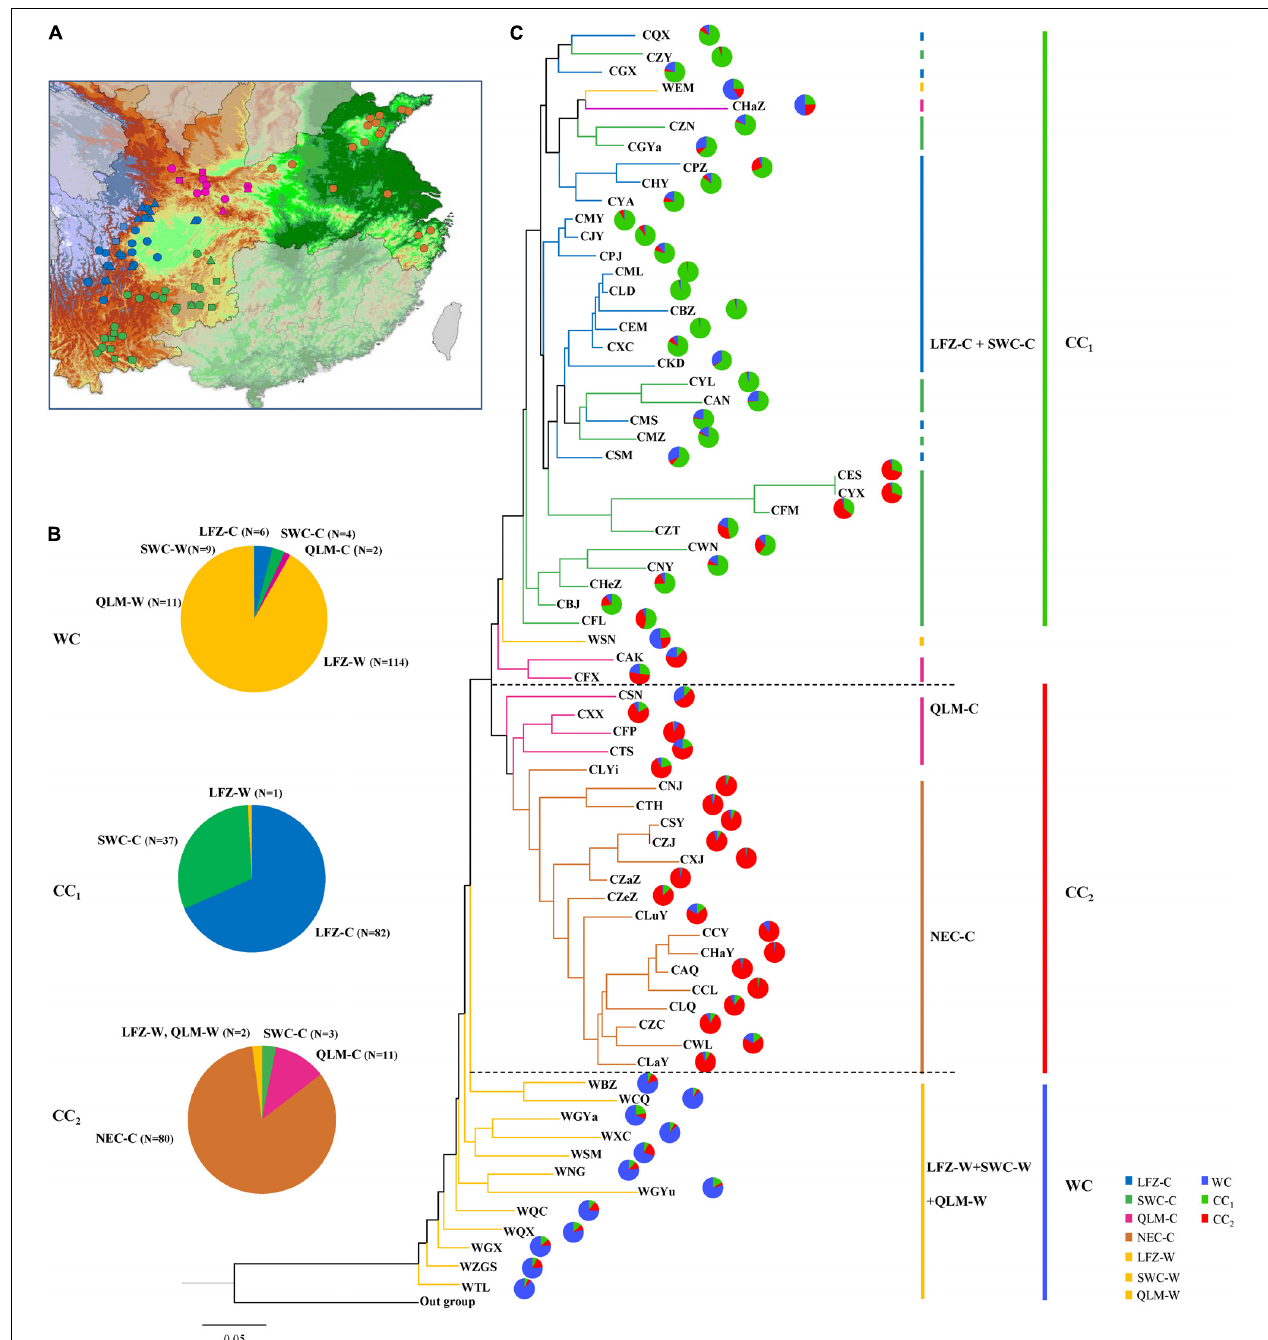
FIGURE 3 | The clustering results of Chinese cherry based on the Bayesian clustering approach and neighbor-joining (NJ) analysis. (A) Sampling population location in four geographical regions. The symbol and color of each population corresponds to those in Figure 1 . (B) Compositions of three genetic clusters (WC, CC 1 , and CC 2 ). (C) Rooted NJ tree constructed based on D A distance and genetic structure patterns of 69 Chinese cherry populations identified by STRUCTURE analysis under the Chinese cherry dataset ( N = 532). In (B,C) , the colors of LFZ-C, SWC-C, QLM-C, and NEC-C populations correspond to those of (A) , whereas LFZ-W, SWC-W, and QLM-W populations are uniformly colored by